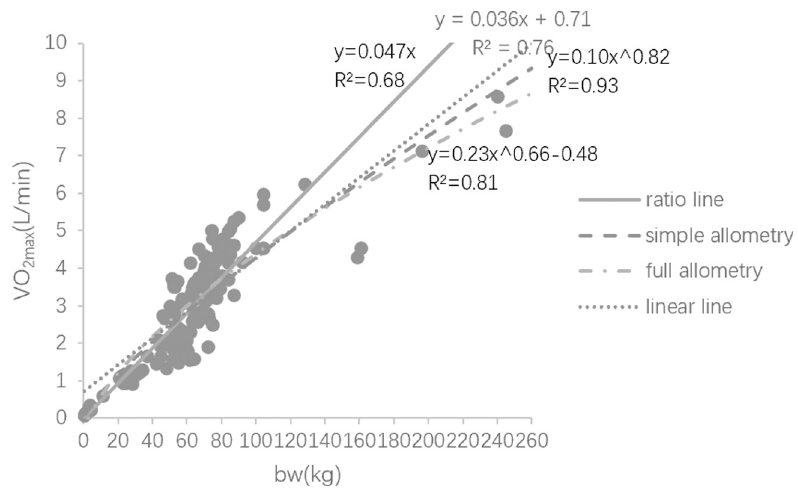
Fig 1. Data distribution and trends in different